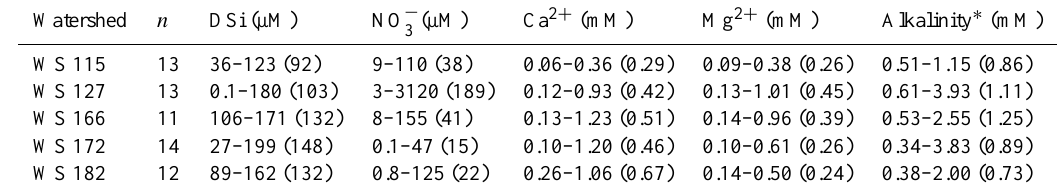
Table 2. Ranges and (median) concentrations of DSi, NO − , Ca 2 + , Mg 2 + , and Alkalinity. The number of samples ( n) only include those 3 that were collected for all constituents on the same dates throughout the October 2008–February 2010 sample period.